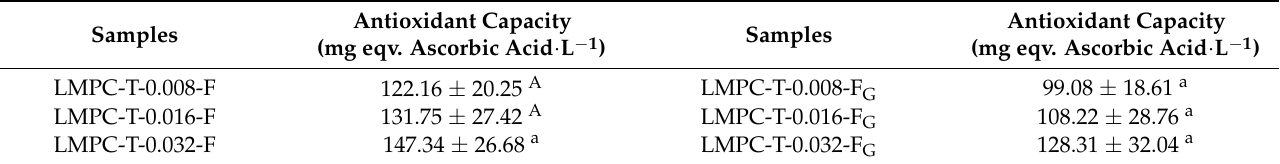
Table 1. Comparison of the antioxidant capacity of LMPC-T-F and LMPC-T-F G . Antioxidant